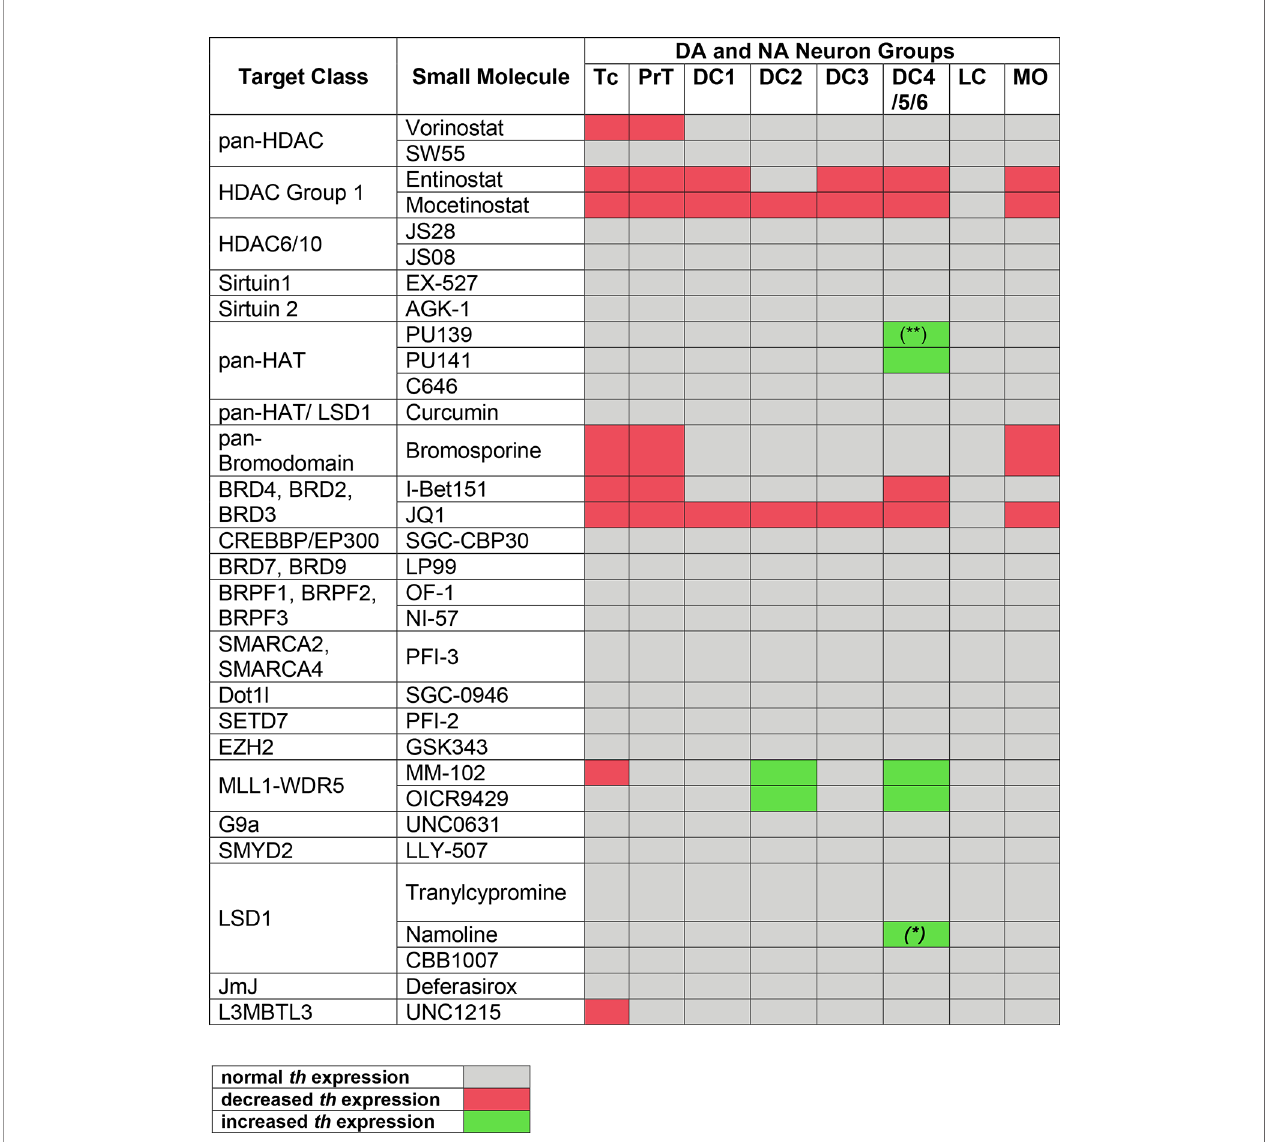
FIGURE 4 | Summary of Primary Screening Results. Table depicting effects on th expression observed in zebra fi sh embryos after treatments with inhibitors shown at left. Only when treatment with at least one compound concentration caused one third or more of the assayed embryos to be affected, th expression was classi fi ed as decreased or increased, respectively. Treatments at 1 to 30 µM were considered, while 100 µM was excluded due to high lethality with most compounds. Color code at bottom: decreased or increased th expression represents both potentially changed expression levels or changed number of expressing cells, which could not be distinguished during qualitative analysis of images. (*) For Namoline, the increase of DC4/5/6 was only observed at 10 µM. (**) For PU139, only 7 out of 23 embryos showed a slight increase in stain